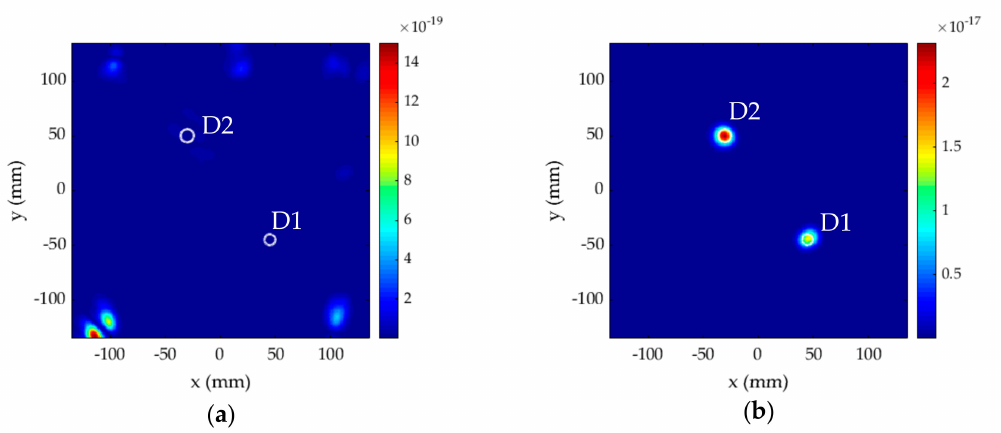
Figure 23. Baseline-free aggregate damage image for multiple damage scenario in pulse–echo configuration: ( a ) without time compensation; ( b ) with time